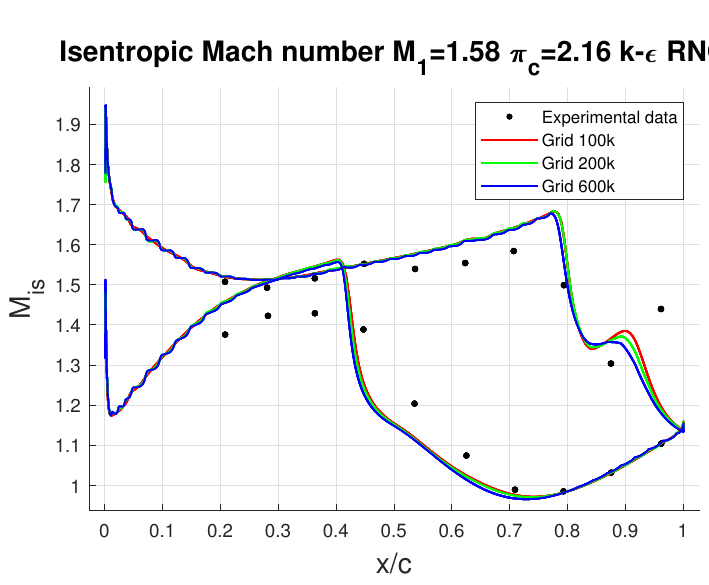
Figure 4. Isentropic Mach number: experimental data and numerical calculations with different grid refinements. k – (cid:101) RNG